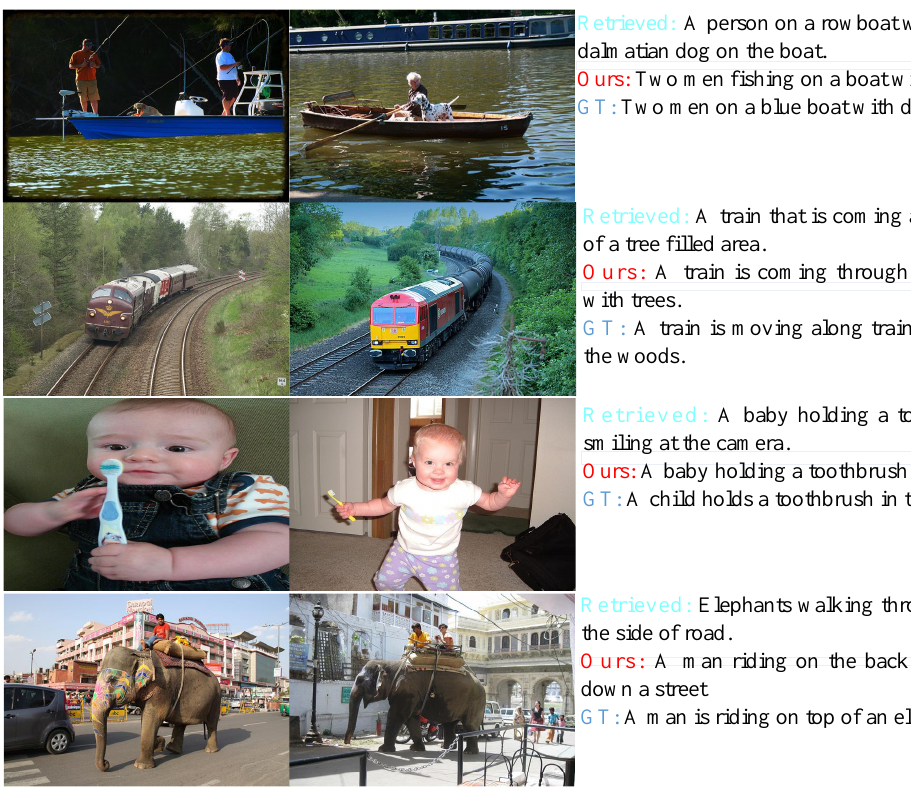
Figure 3. Examples of the retrieved similar sequence and the captions generated by our model on MSCOCO validation set. “Retrieved” indicates one of the retrieved five similar sequences by computing the image pairs visual similarity. “Ours” is the generated result by our approach. “GT” denotes one ground-truth